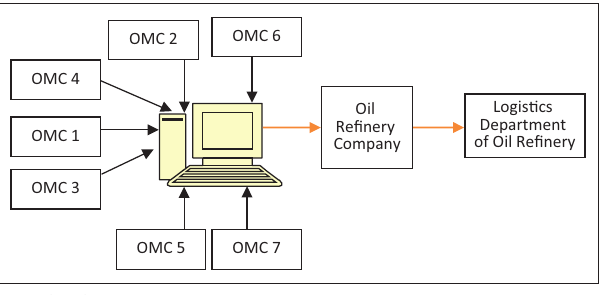
FIGURE 1: Oil marketing companies ordering refined petroleum products